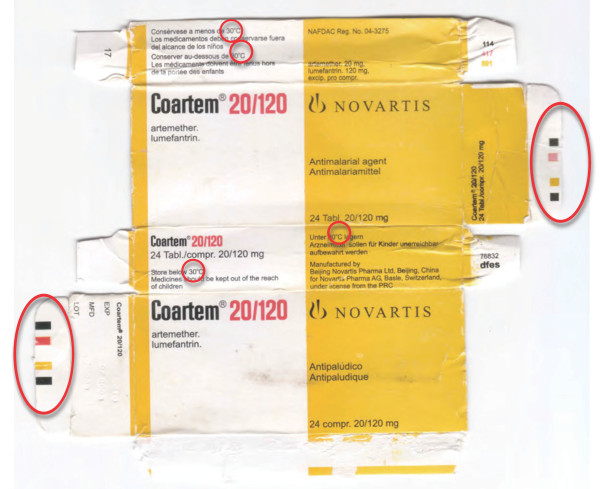
Counterfeit 'Coartem' labelled as made by 'Beijing Novartis Pharma Ltd, Beijing, China for Novartis Pharma AG, Basle, Switzerland' (Gh 09/02). Differences from genuine sample (Figure 16) in red circles.